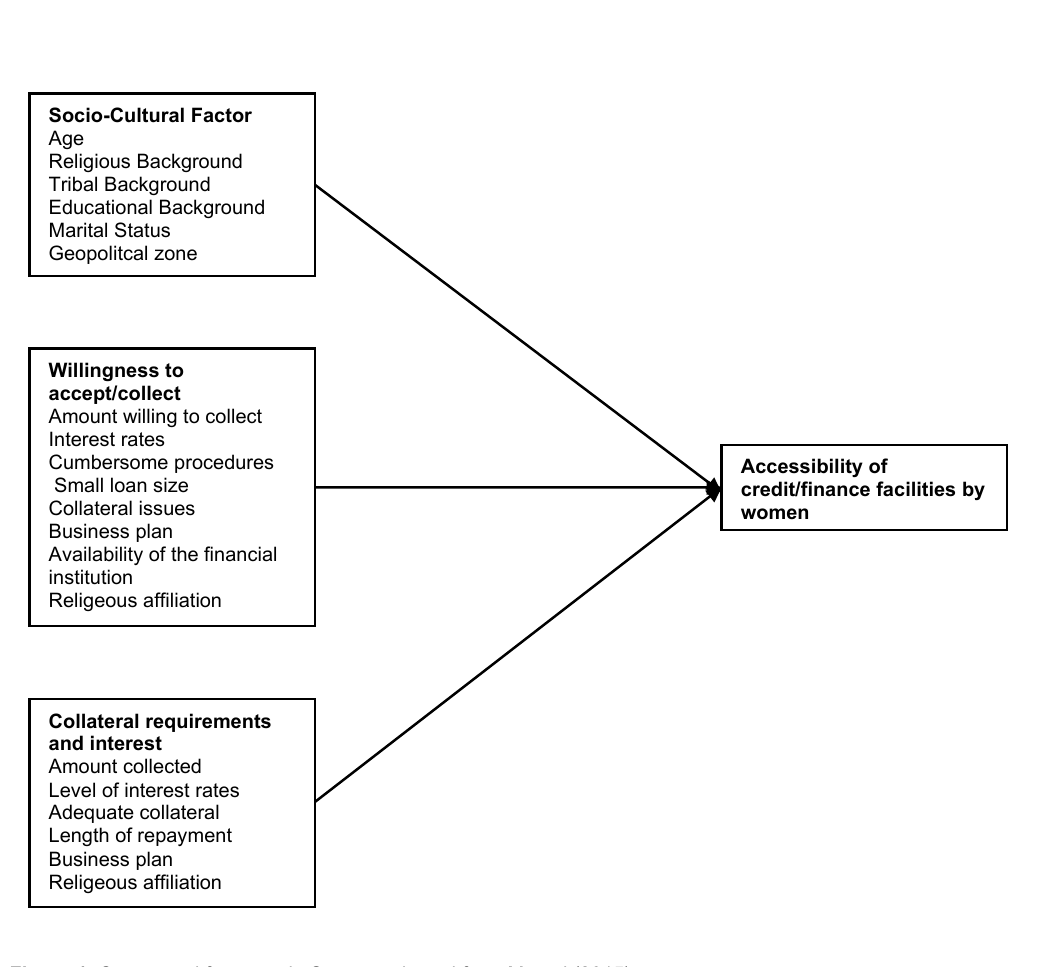
Figure 1. Conceptual framework. Source: adapted from Muntai